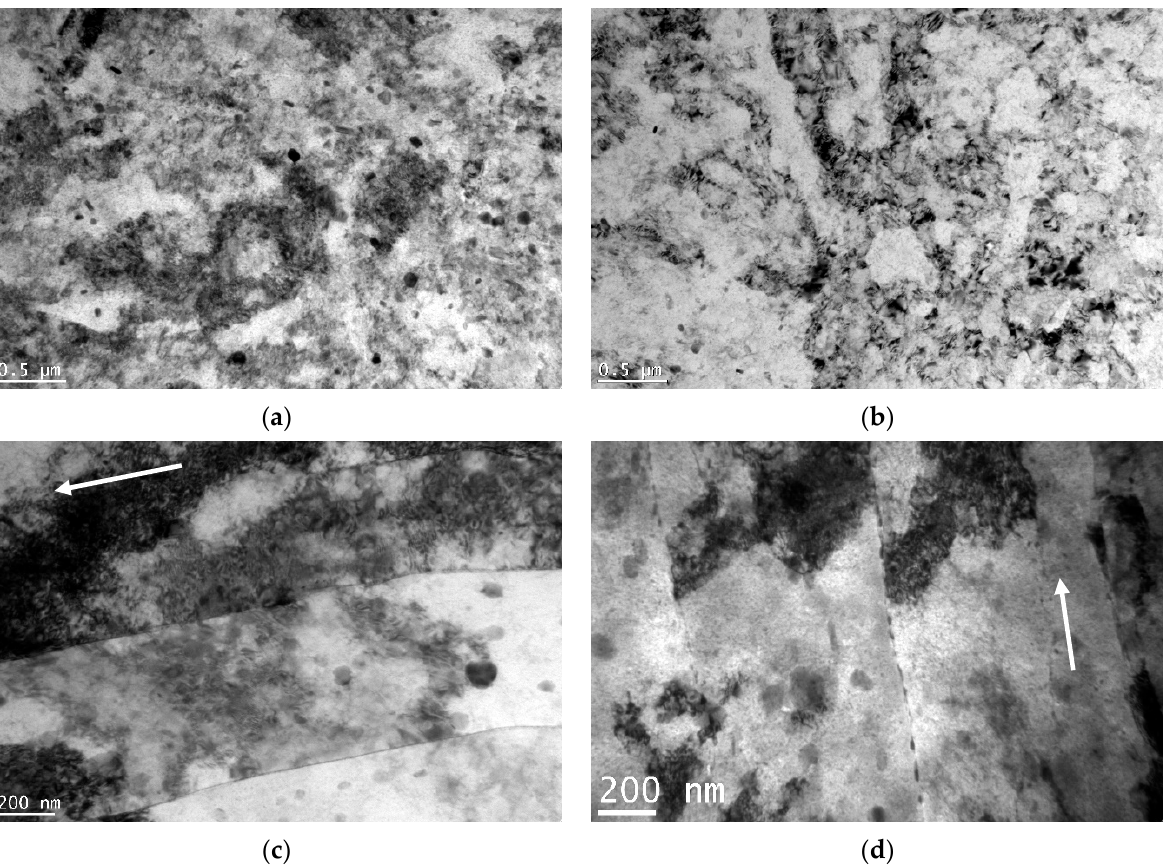
Figure 5. TEM micrographs of the samples: ( a ) HT1 transverse plane, ( b ) HT2 transverse plane, ( c ) HT1 longitudinal plane, and ( d ) HT2 longitudinal plane; white arrows indicate the direction of the hydrostatic extrusion.